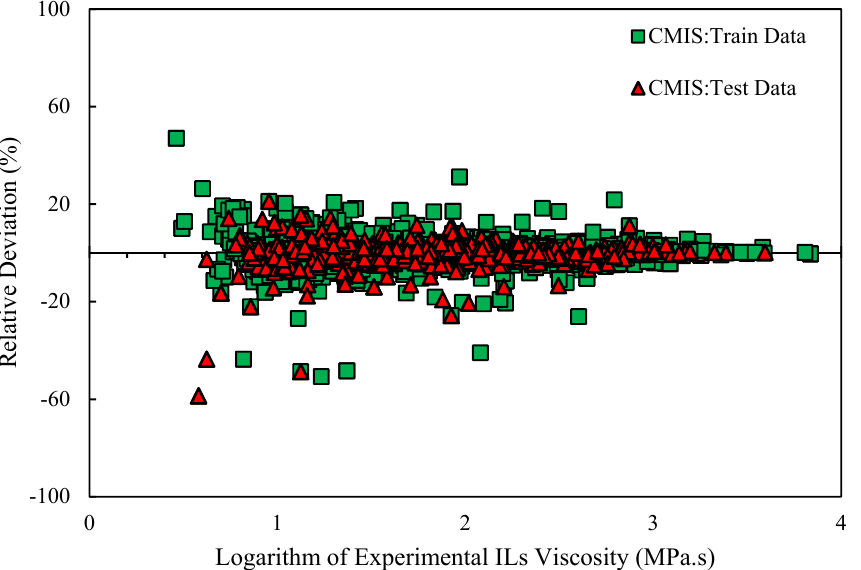
Figure 12. Relative deviation distribution for developed CMIS model in this study for estimation of the viscosity of ILs based on Model (III).